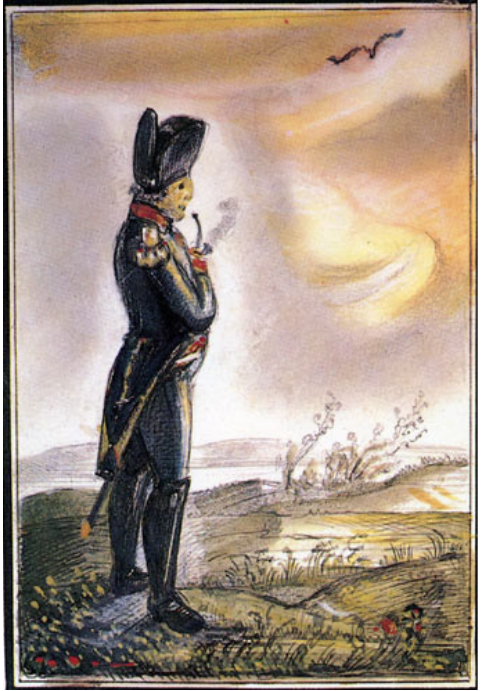
Figure 42. Konstantin Batiushkov. Napoleon , 1828 (?). Literary Museum of the Institute of Russian Literature (Pushkin House) of the Russian Academy of Sciences, Saint Petersburg.